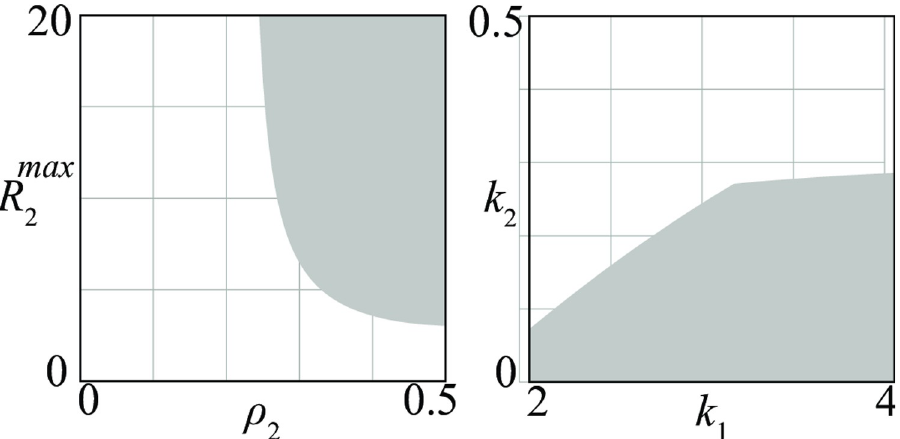
Fig 9. Sets of D—A conflicts (shaded regions) where a periodic stalemate is the only possible outcome.